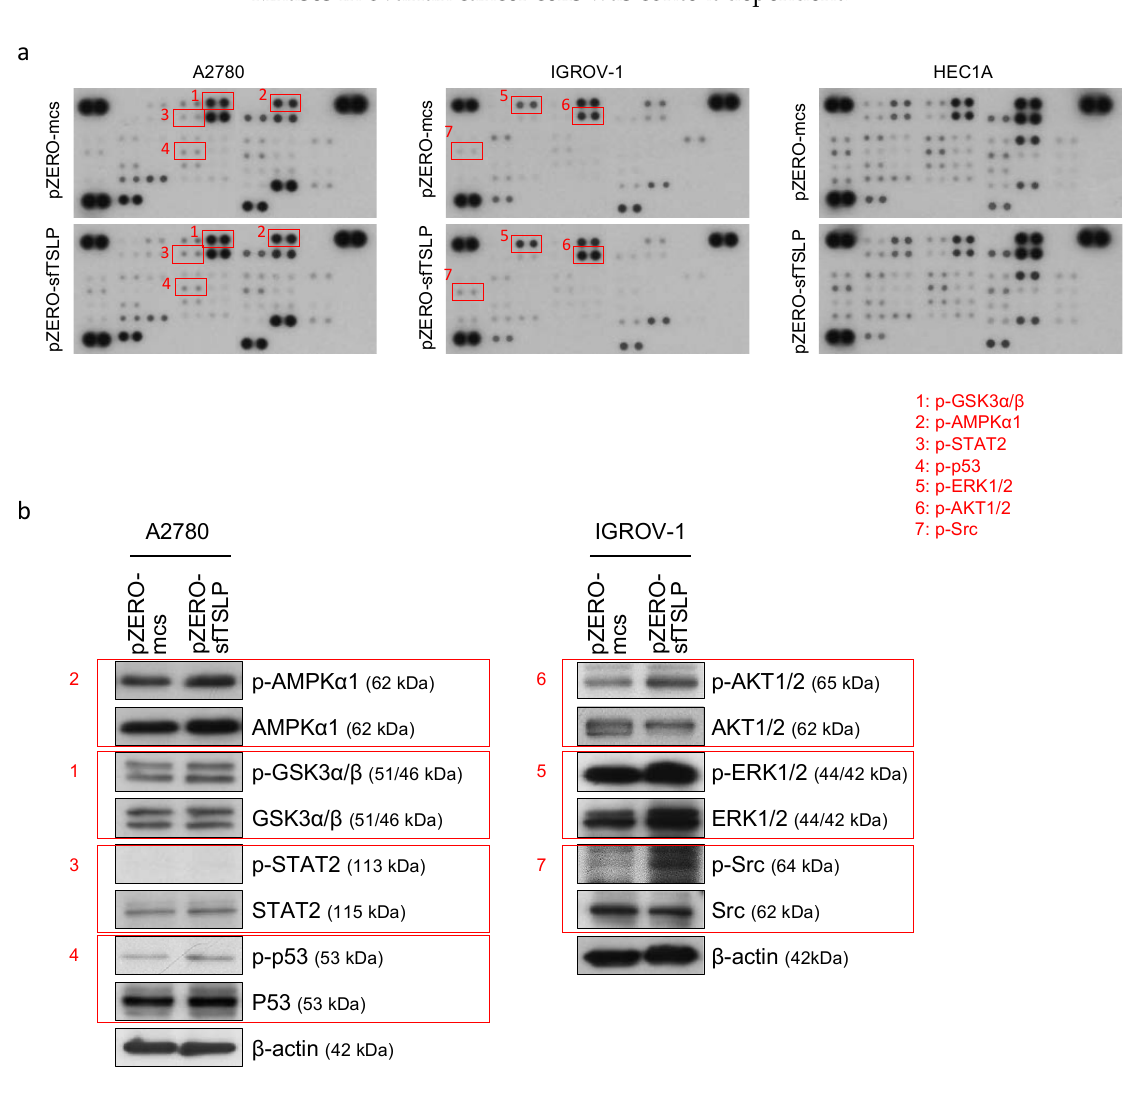
Figure 5. Cont Figure 5. Cont .